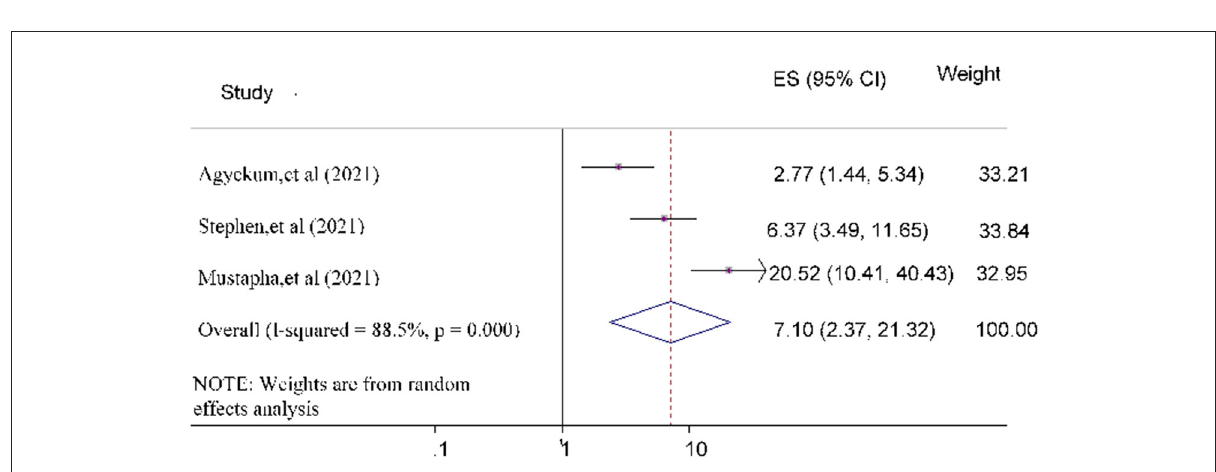
FIGURE10 Forest plot depicting the relationship between government trust and COVID-19 vaccine acceptance among the study